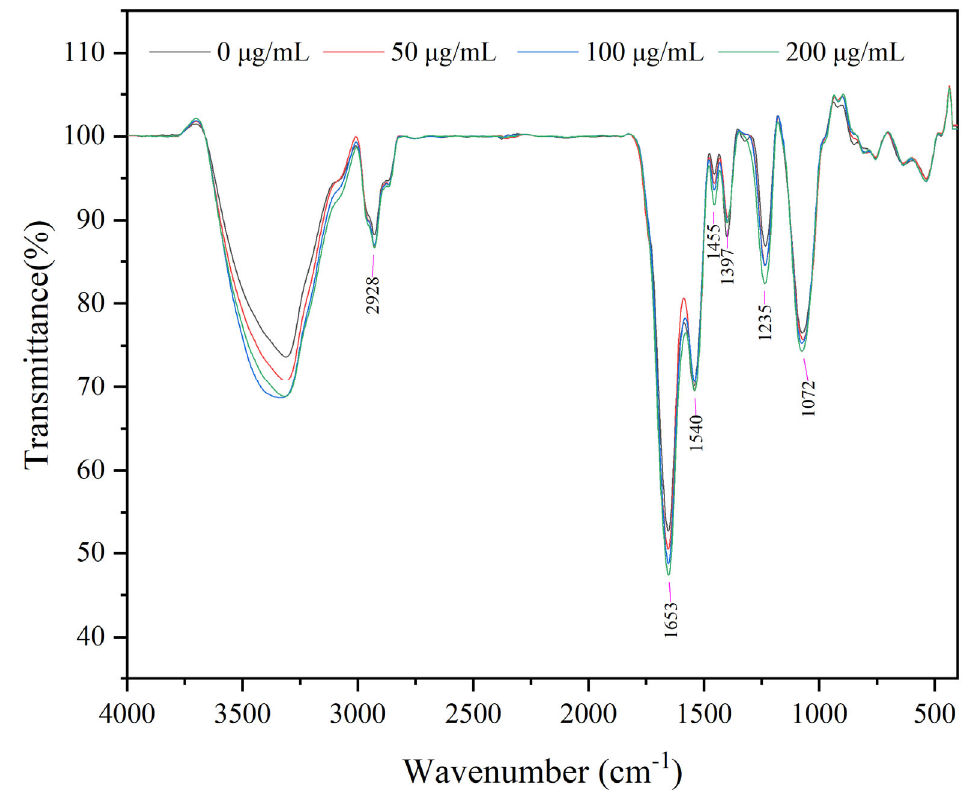
Figure 7. FT ‐ IR images of L. monocytogenes treated with different concentrations of